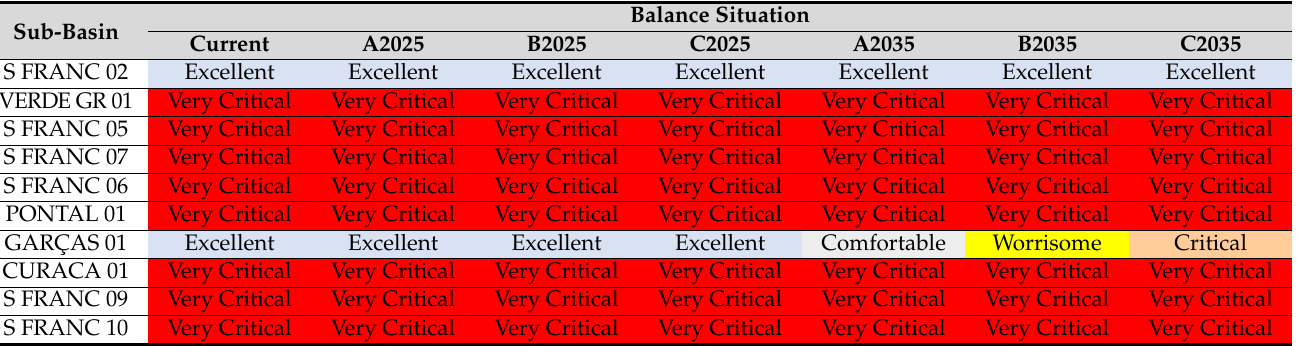
Table 7. Examples of surface water balance (Acquanet)—industry. See Table 2 for the corresponding classification. See Supplementary Materials S8.